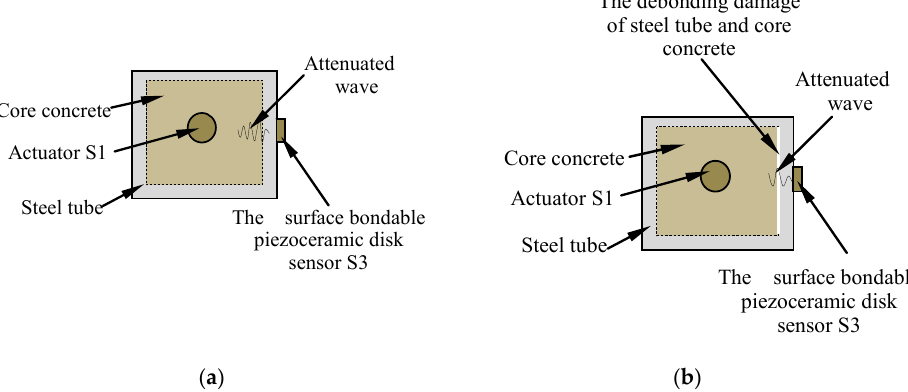
Figure 4. Active sensing approach to debonding detection of core concrete and steel tube. ( a ) The structure in a healthy state; ( b ) The structure under the debonding damage.